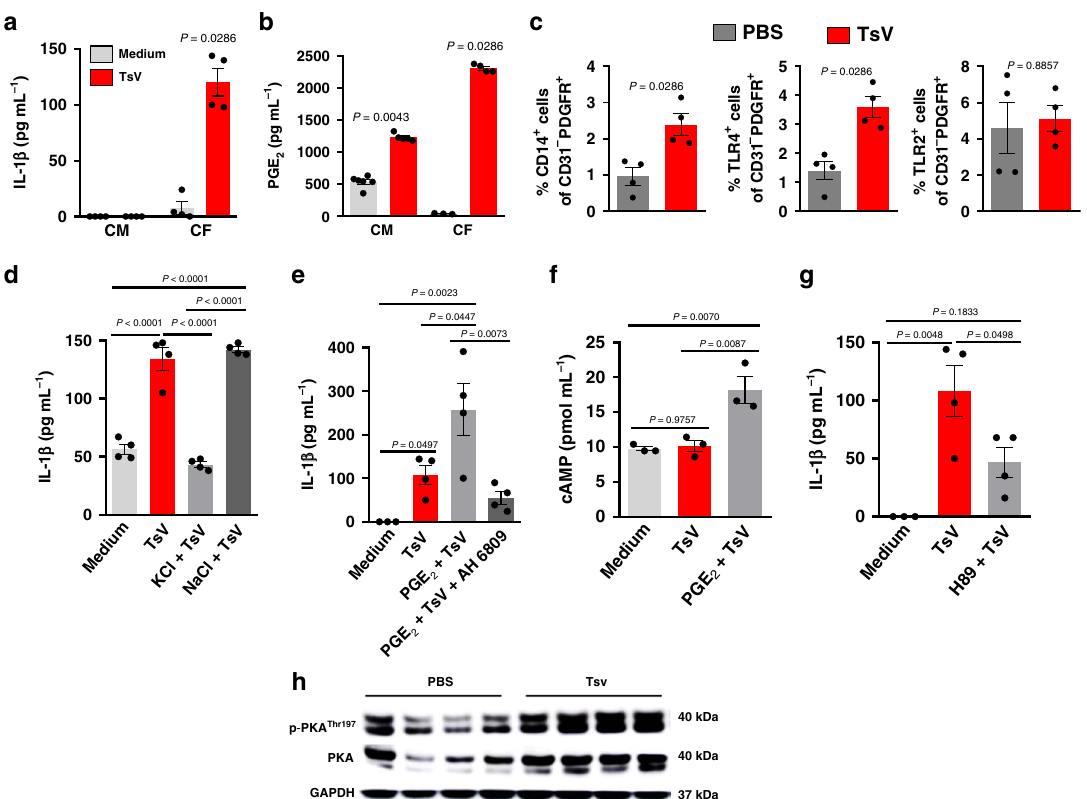
Fig. 2 Cardiac fi broblasts release PGE2 and IL-1 β upon TsV stimulation. a IL-1 β and b PGE 2 concentration in supernatants of primary cultures of cardiac fi broblasts (CFs) and cardiomyocytes (CMs) incubated with medium or TsV ( a , b , n = 4 – 5 wells/per condition, one experiment). c Percentage of CFs (gated as CD31 - PDGFR + ) expressing CD14 + , TLR4 + , or TLR2 + as assessed by fl ow cytometry of heart cell suspensions from mice inoculated with PBS or TsV ( n = 4/group one experiment). d IL-1 β concentration in the supernatants of CFs incubated with medium or TsV with or without KCl (50 mM) or NaCl (50 mM). e IL-1 β concentration in supernatants of CFs pre-treated or not with PGE 2 10 µ M 10 min before TsV, in the presence or absence of EP2 antagonist (AH6908, 1 µ M, 30 min before PGE 2 ), followed by stimulation with TsV ( e , f , n = 4 wells/per condition, one experiment). f cAMP in primary CFs,